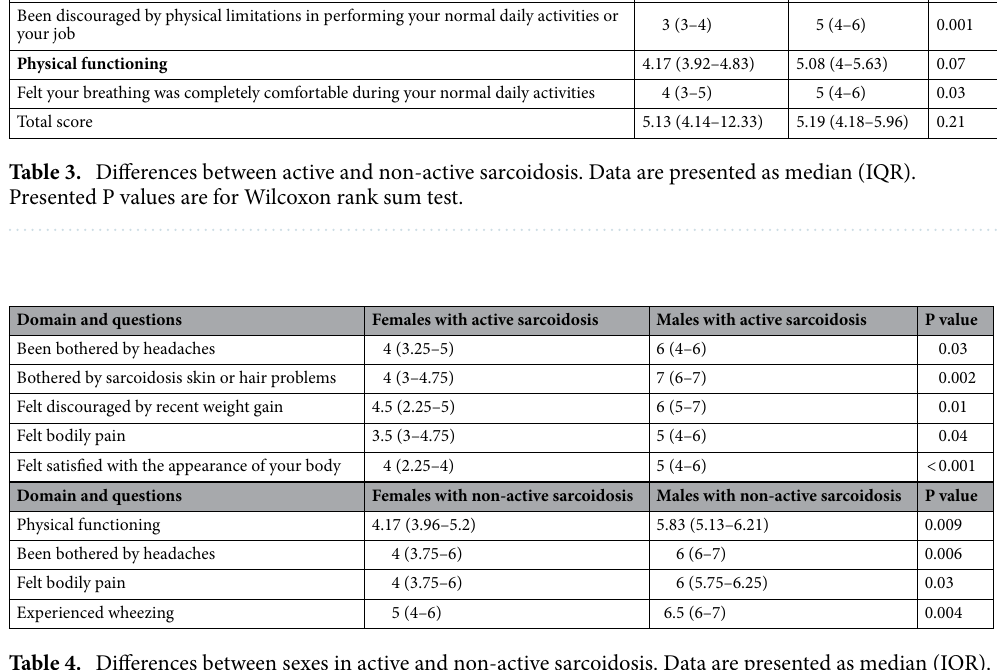
Table 4. Differences between sexes in active and non-active sarcoidosis. Data are presented as median (IQR). Presented P values are for Wilcoxon rank sum